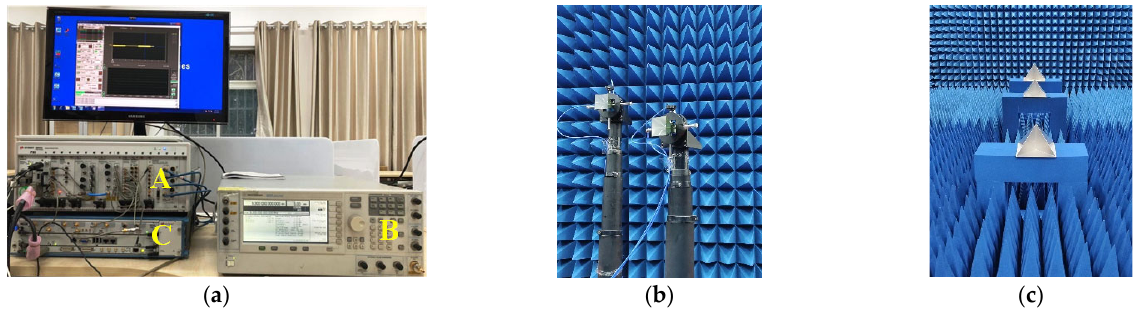
Figure 8 . Measurement scene in the anechoic chamber: ( a ) Experiment system; ( b ) Antennas; ( c ) Targets.